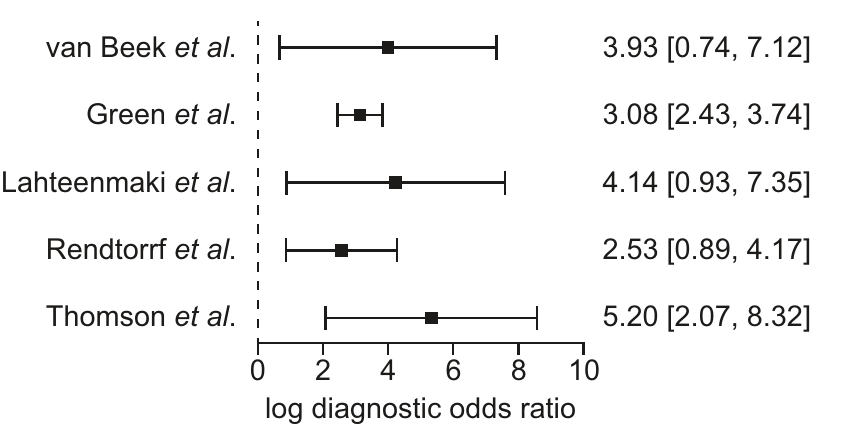
Fig 3. Forest plot of 95% confidence limits for the log-adjusted diagnostic odds ratio for the five studies listed in Table 1. The vertical dashedline denotesthe line of no effect. Visual inspectionshows that each study is statisticallysignificantin its own right, that the intervals overlap to a great extent, and that therefore the studies are unlikelyto be heterogeneous. https://doi.org/10.1371/journal.pone.0181377.g003 The optimal threshold maximizes the chance of a correct classification for an arbitrary sur- vivor of childhood cancer. In order to quantify FSH levels that minimize misdiagnosis of azoo- spermia, a range of threshold FSH values for the diagnosis of azoospermia were calculated,